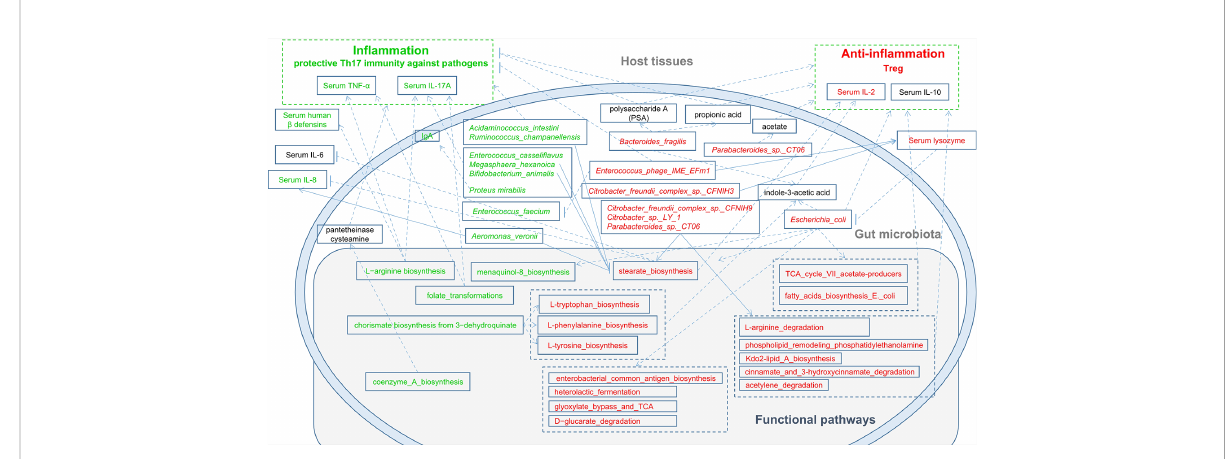
FIGURE 10 A schematic diagram showing the main functions and cytokines of the gut microbes that had a predicted RAU association. Red text denotes enriched functions, species and cytokines in RAU patients. Green text denotes depleted functions, species and cytokines in RAU